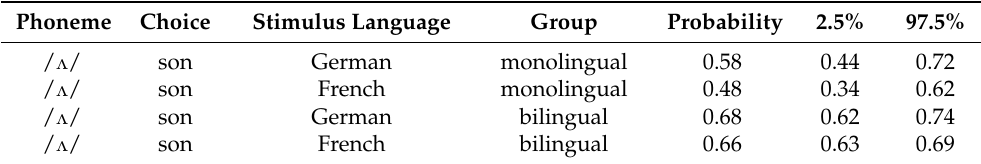
Table 10. Most probable responses given / 2 / in French and German by L1 Spanish monolinguals and L1 Spanish bilinguals.